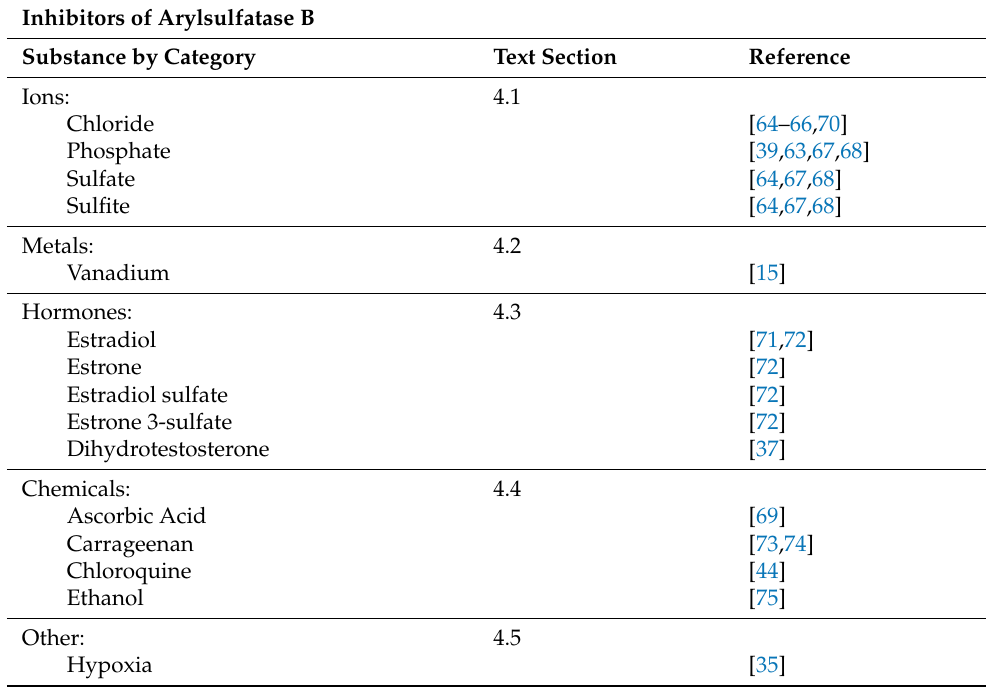
Table 2. Inhibitors of Arylsulfatase B are presented in Section 4. Effects of other metals have been tested, revealing that barium had no impact on ARSB, but inhibited ARSA